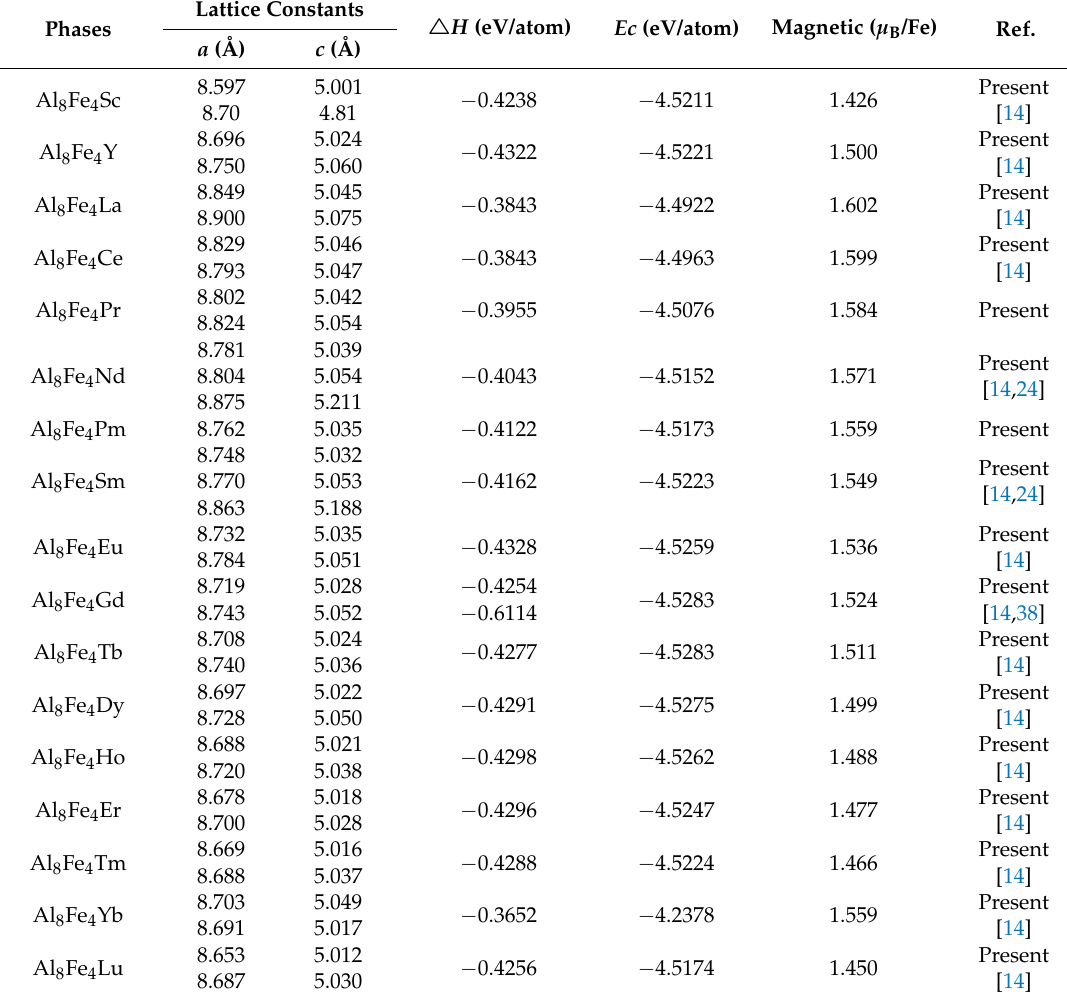
Table 1. Lattice constants, formation enthalpy, cohesive energy, and magnetic moments of Al 8 Fe 4 RE